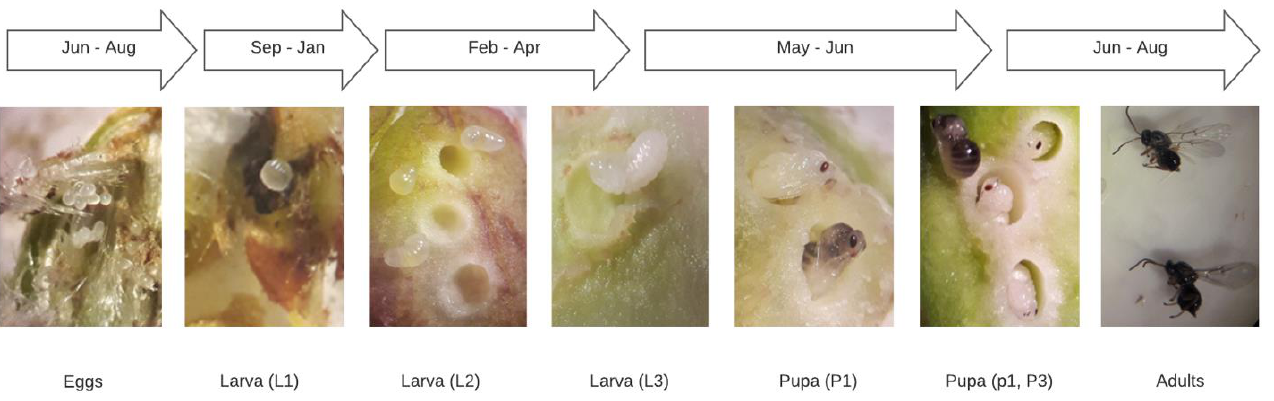
Figure 3. Developmental stages of D. kuriphilus .